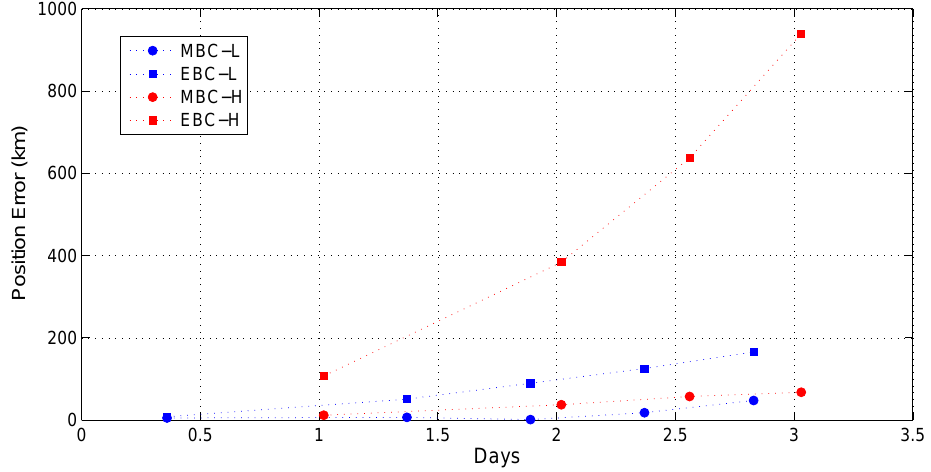
Figure 5. Orbit Propagation Error for Iridium-52